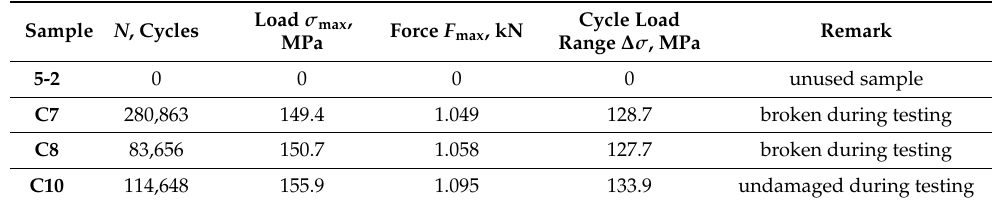
Table 1. Cyclic fatigue test conditions for Al wires of A50 cables.